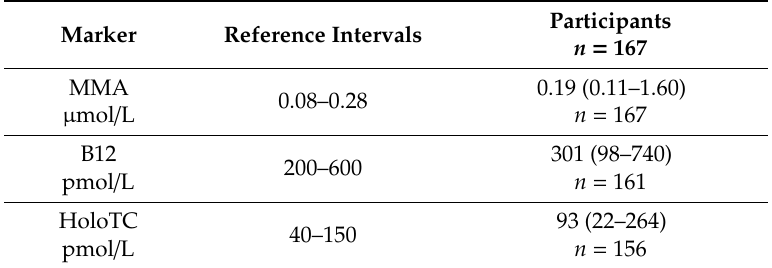
Table 1. Plasma markers of B12 status at baseline 1